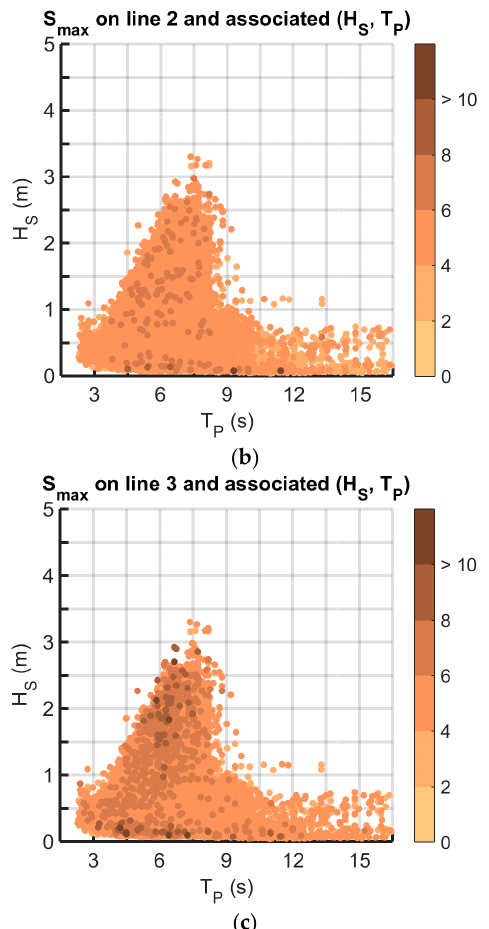
Figure 10. Summary of the measured standard score of the maximum mooring loads S max at SWTMF and of the associated environmental conditions for ( a – c ) lines 1–3.